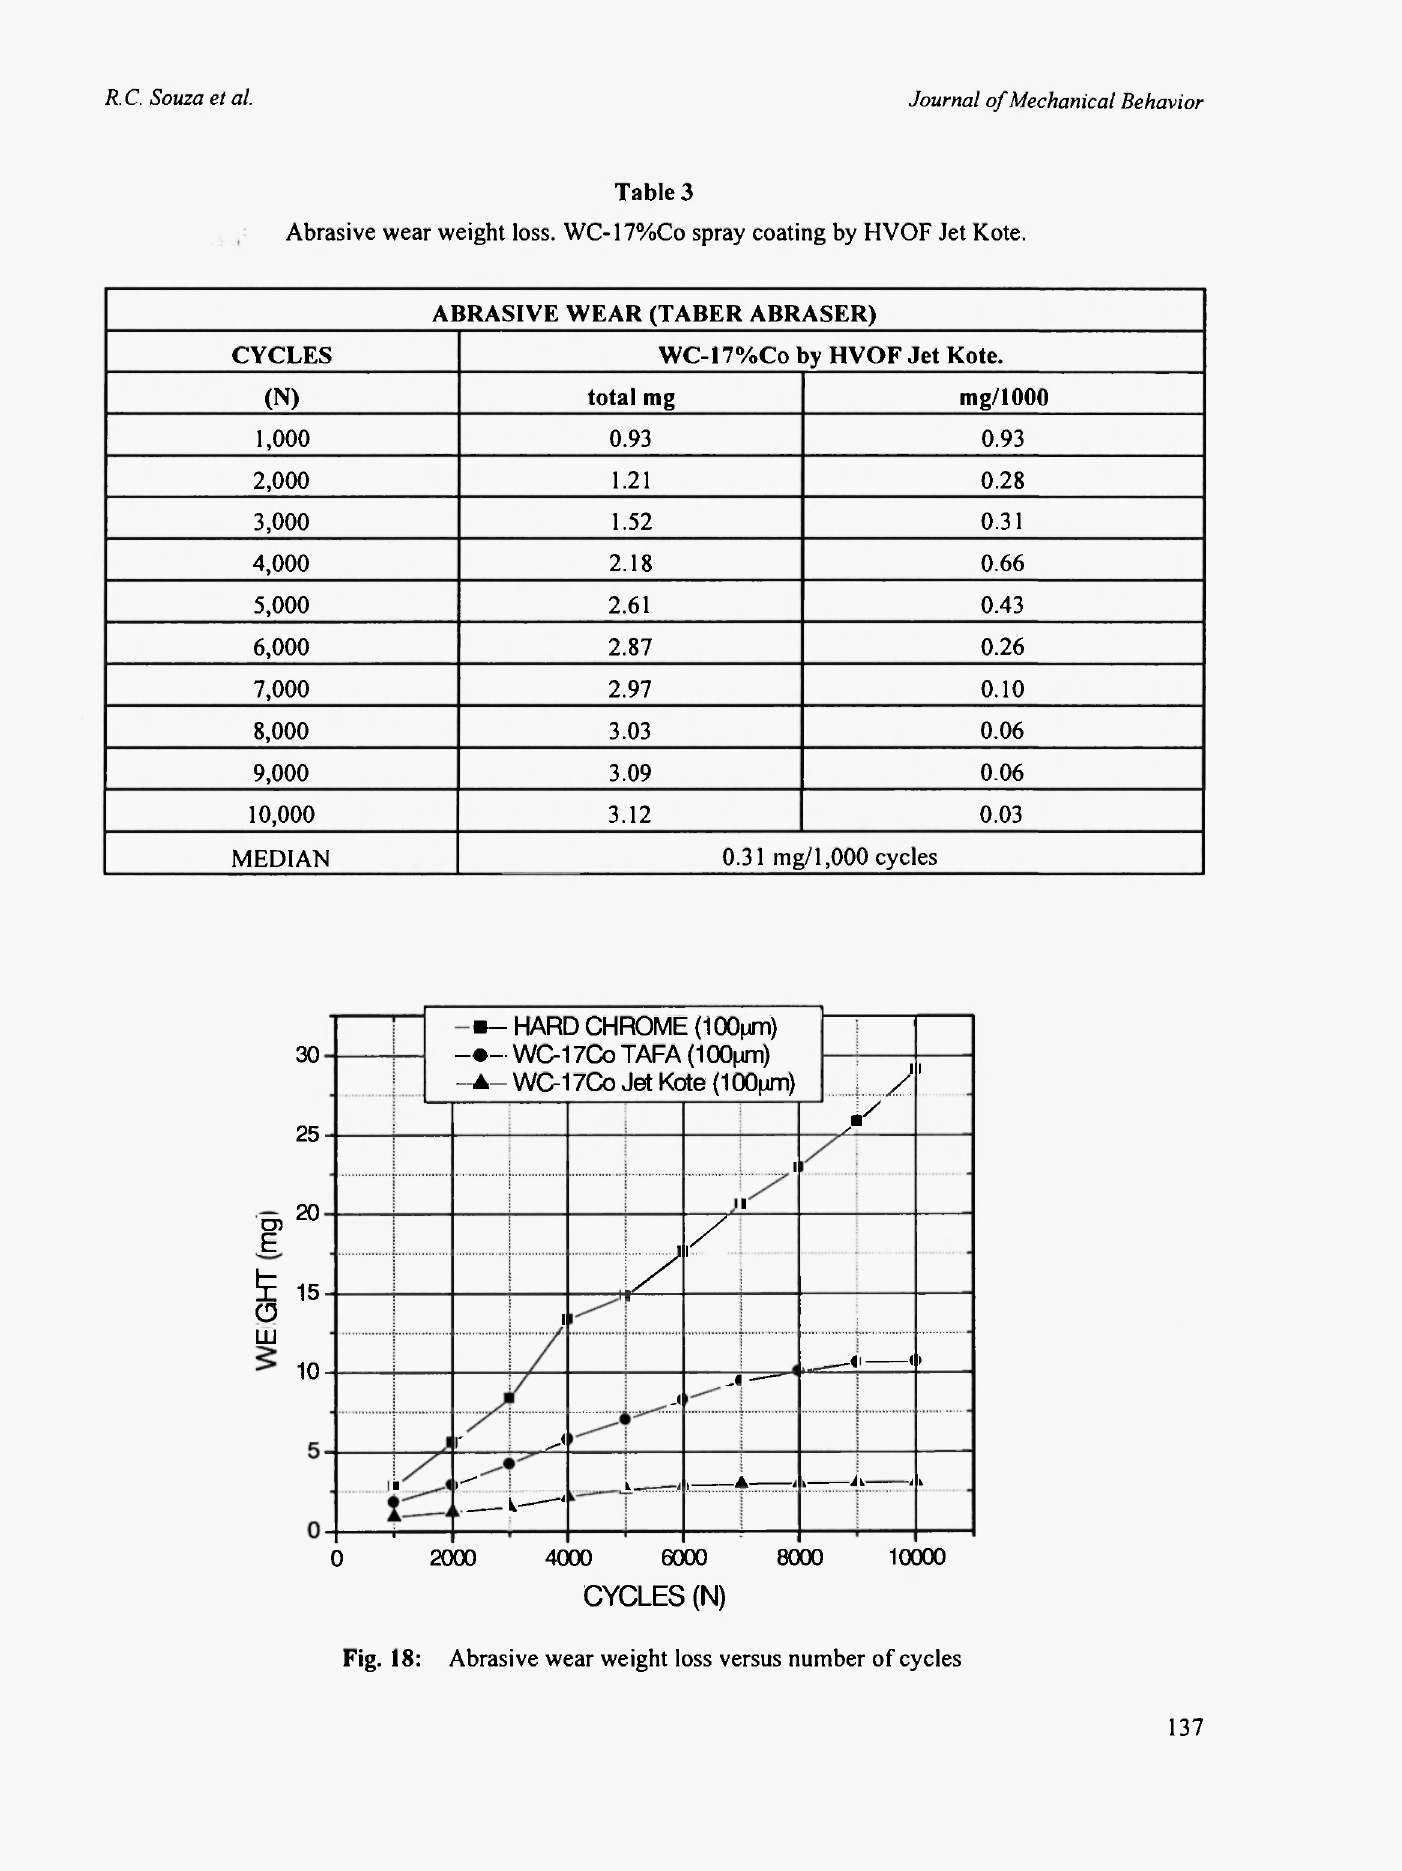
Fig. 18: Abrasive wear weight loss versus number of cycles